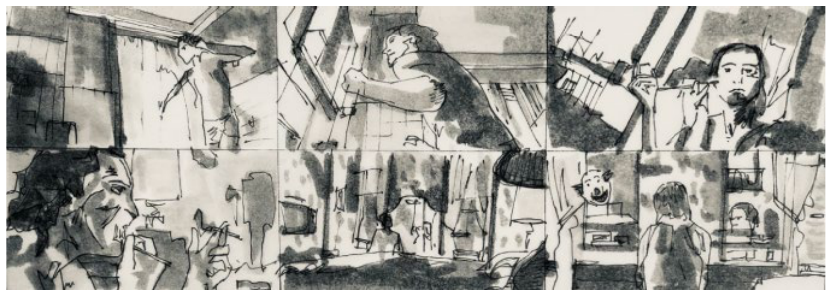
Figure 22 Study of light and shadow and the viewer’s constantly changing perspective of